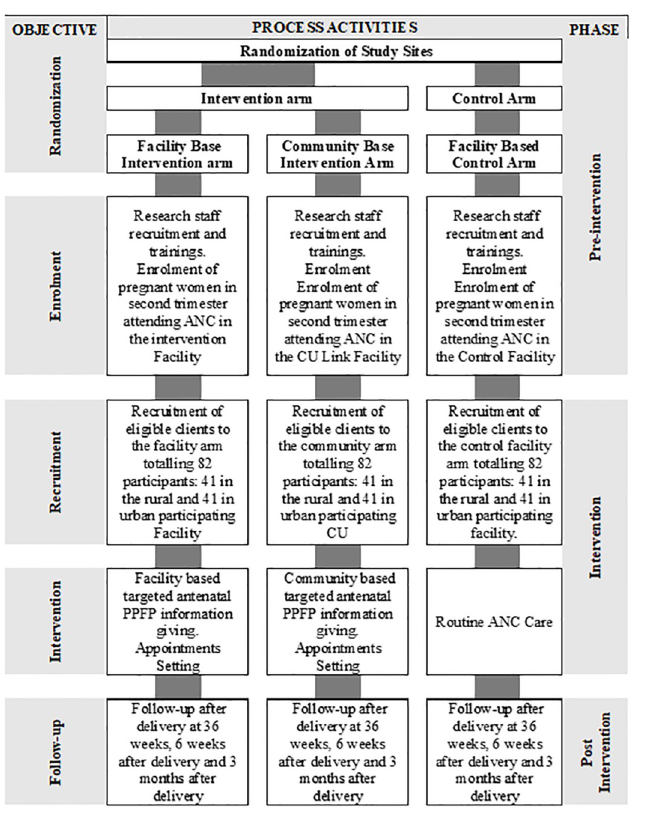
Fig 2. Phases of the clinical